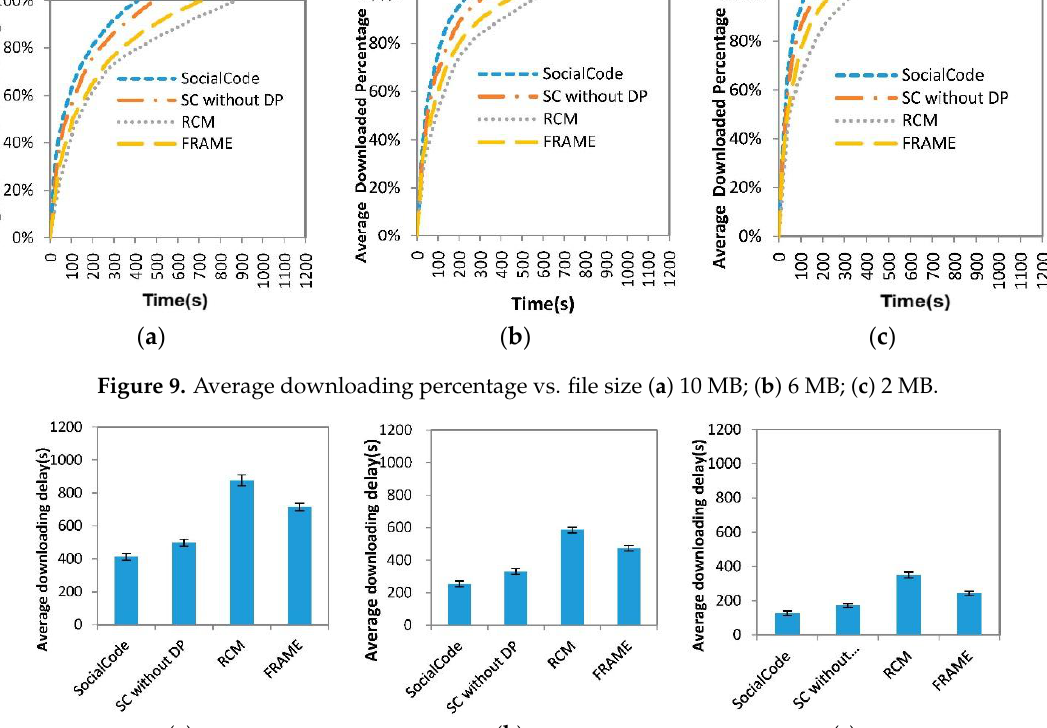
( c ) Figure 11. Average credit vs. file size ( a ) 10 MB; ( b ) 6 MB; ( c ) 2 MB.